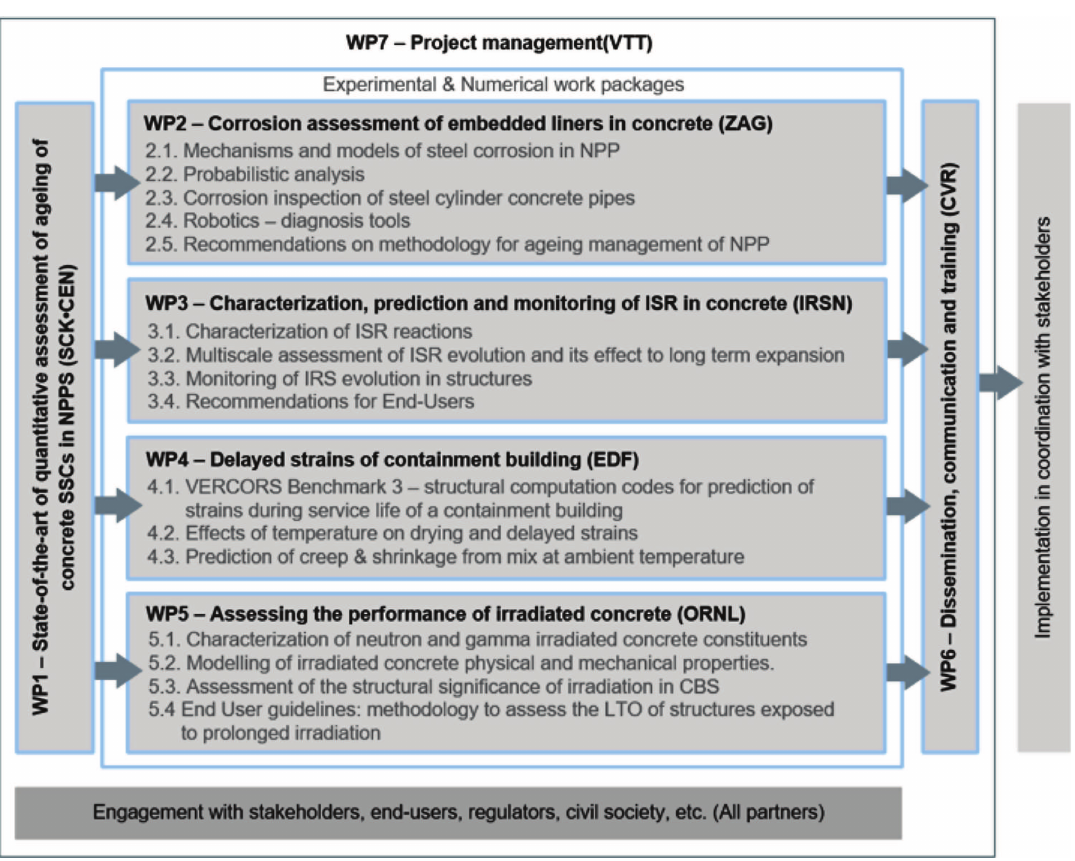
Fig. 6. Overall structure of the ACES work